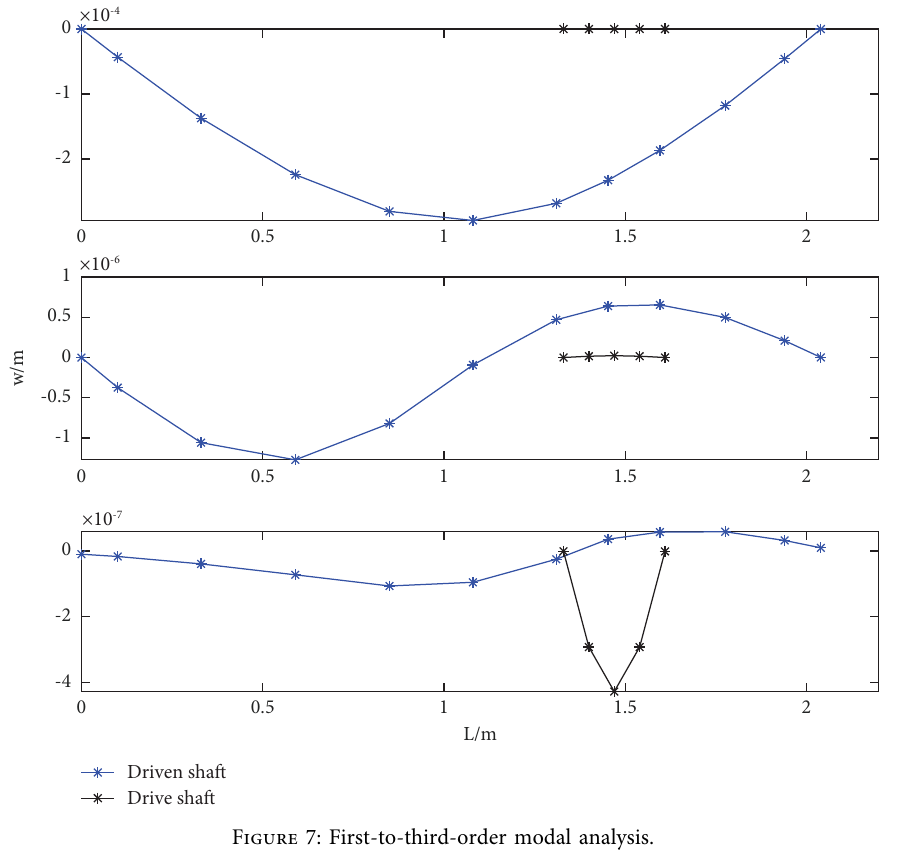
Figure 7: First-to-third-order modal